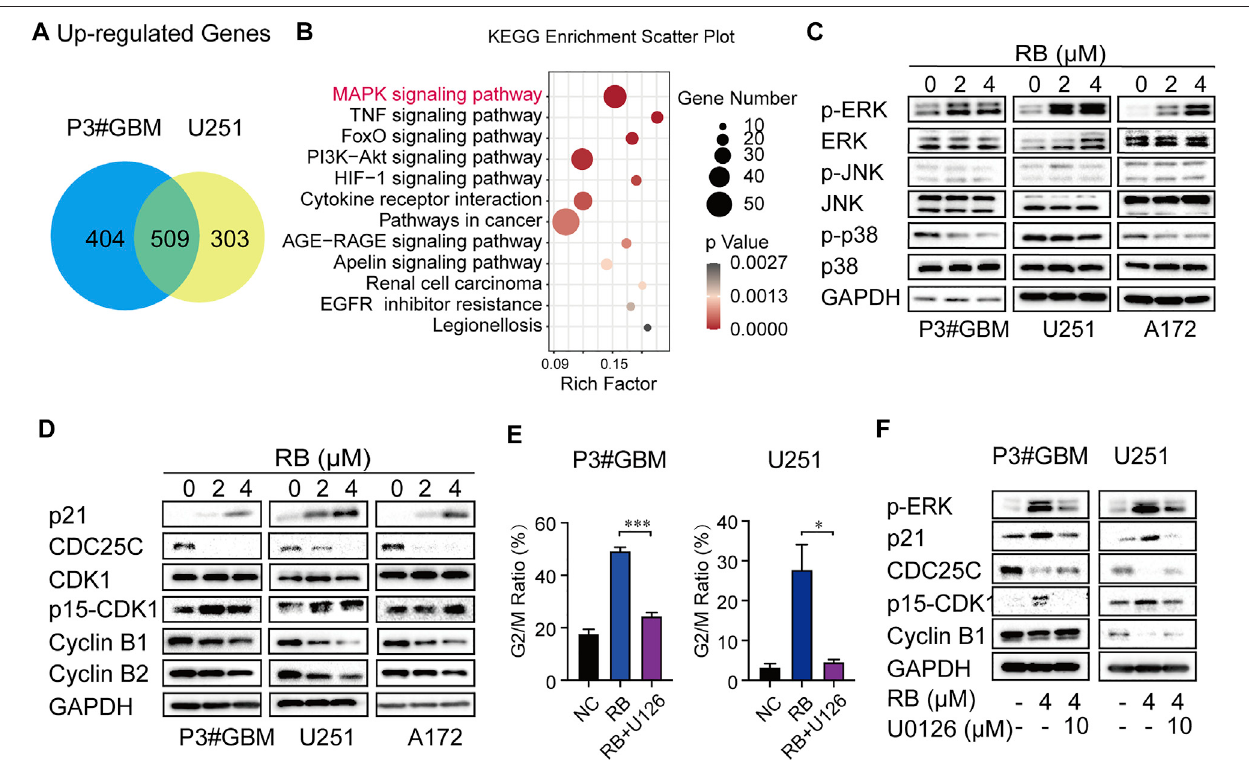
FIGURE 3 | Activation of the ERK/MAPK pathway involves RB-induced G2/M arrest in GBM cells. (A) Intersections of genes with upregulated expression in P3#GBM and U251 cells treated with 4 μ M RB compared with control cells. (B) KEGG pathway enrichment analysis of intersecting genes with upregulated expression. (C) Western blot analysis of total and phosphorylated protein levels of ERK, JNK and p38 after 2 or 4 μ M RB treatment for 48 h in P3#GBM, U251 and A172 cells comparedwithcontrolcells. (D) G2/Mphase-relatedproteinexpressionafterRBtreatmentfor48 hinP3#GBM,U251andA172cellsanalyzedbywesternblot. (E) P3#GBM and U251 cells were pretreated with U0126 (10 μ M; ERK inhibitor) for 6 h, and then, 4 μ M RB was incubated for another 48 h. Graphic representation of percentagesofG2/Mphasecellscalculatedfromeachgroupwereshownin SupplementaryFigureS1C . (F) Westernblotanalysisoftheproteinexpressionofp-ERK, p21,CDC25C,p15-CDK1andcyclinB1inP3#GBMandU251cellspretreatedfor6 hwithU0126(10 μ M)andthentreatedwith4 μ MRB.Datafromthreeindependent experiments were displayed as the mean ± SEM by one-way ANOVA (E) . * p < 0.05; ** p < 0.01, and *** p <